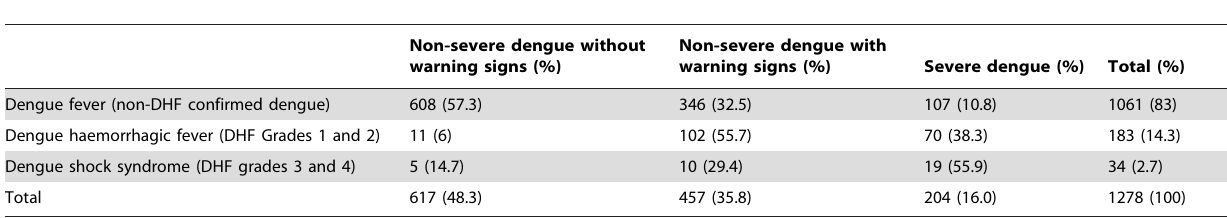
Table 3. World Health Organization 1997 versus 2009 three-category classification of dengue based on 1278 adult cases confirmed by polymerase chain